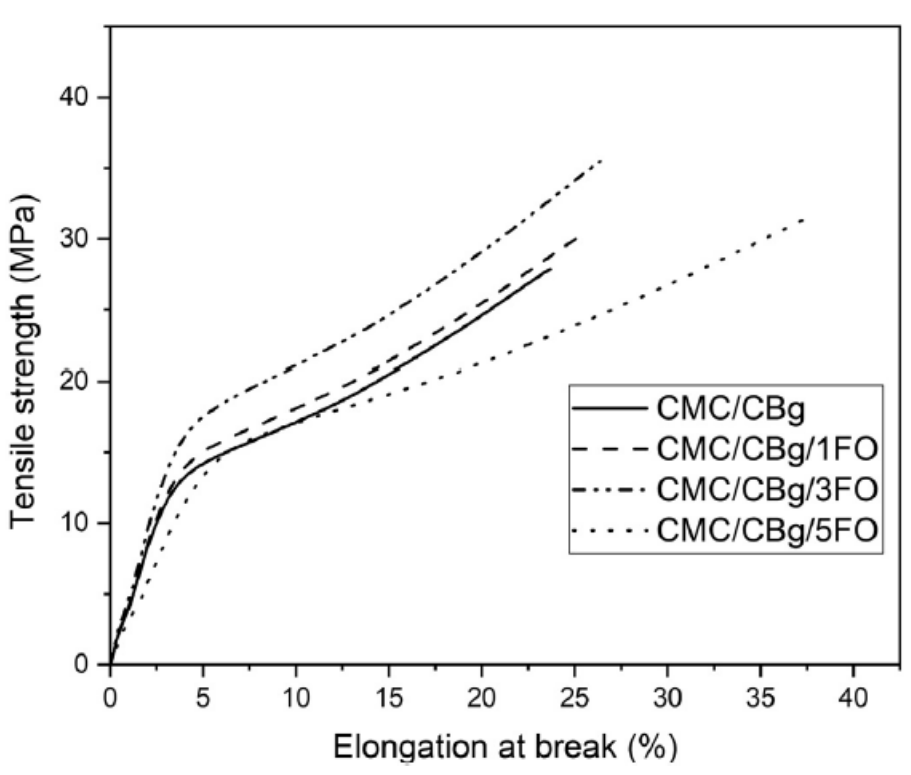
Figure 22. Tensile strength vs. elongation at break for carboxymethyl cellulose (CMC)/chitosan biguanidine hydrochloride (CBg) and CMC/CBg/ frankincense oil (FO) films. Reproduced with permission from [16]. (Copyright 2019 Elsevier).